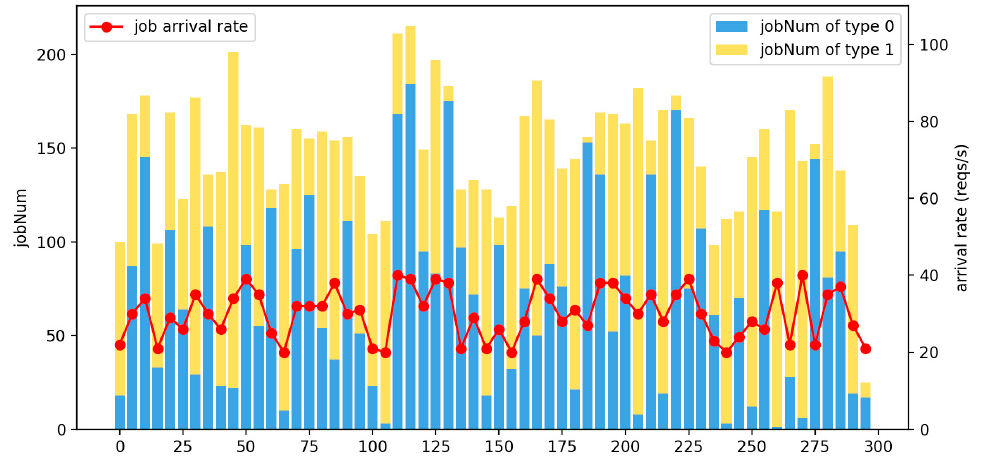
Figure 8. Job arrival rate in low-frequency workload mode.